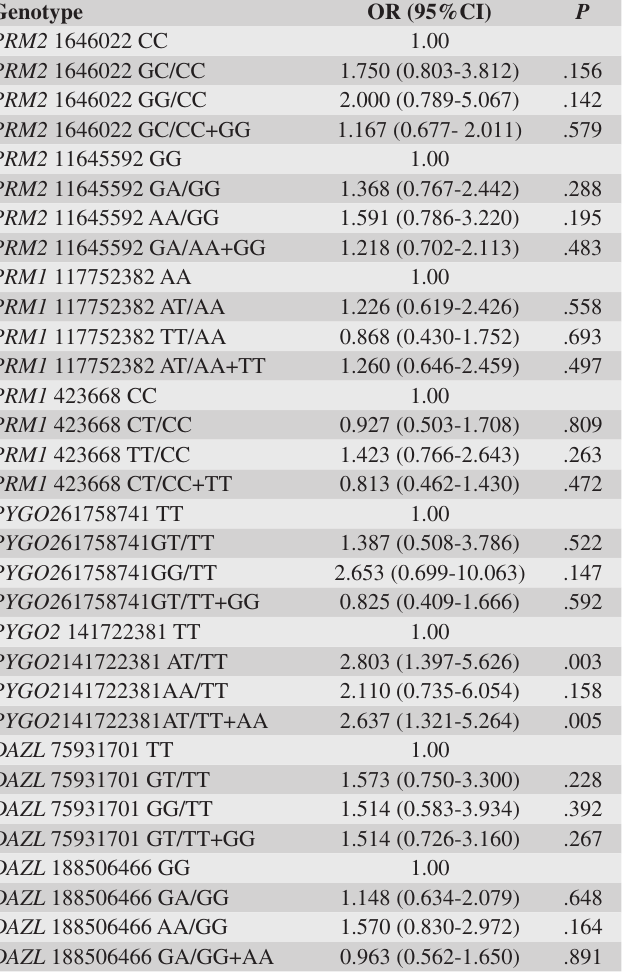
Table 4. Hardy-Weinberg Equilibrium (HWE) Status in Case and Control Group Genotype